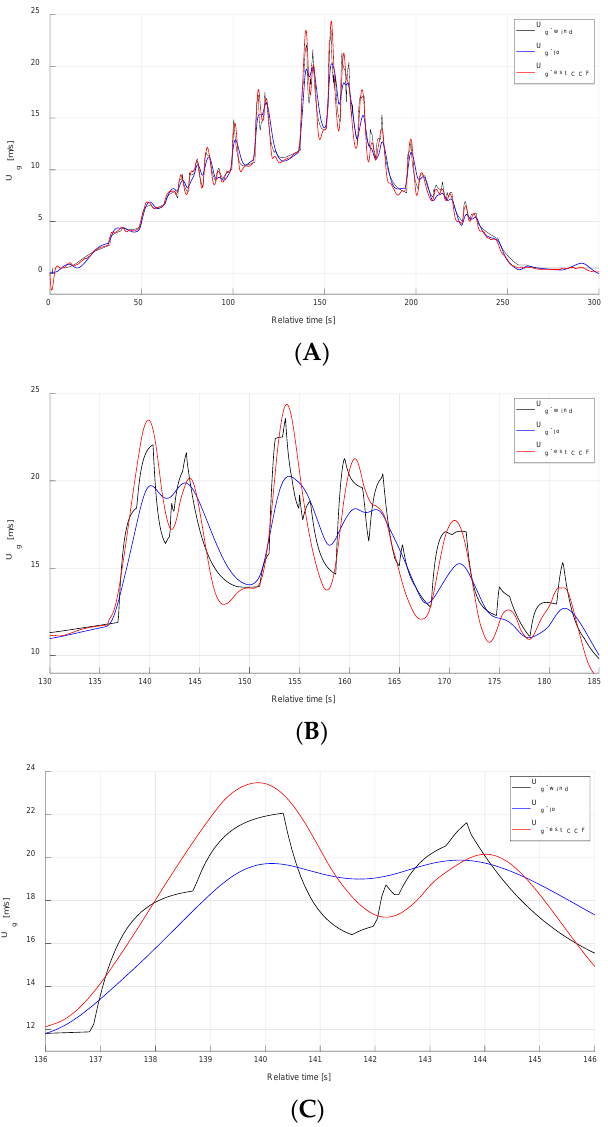
Figure 21. Comparison of the gust value with the estimation results (cascaded complementary filter, estimation delay reduced by 1.5 s)—flight crossing a gust area; ( A ) whole simulation, ( B ) several selected gusts, and ( C ) single selected gust.